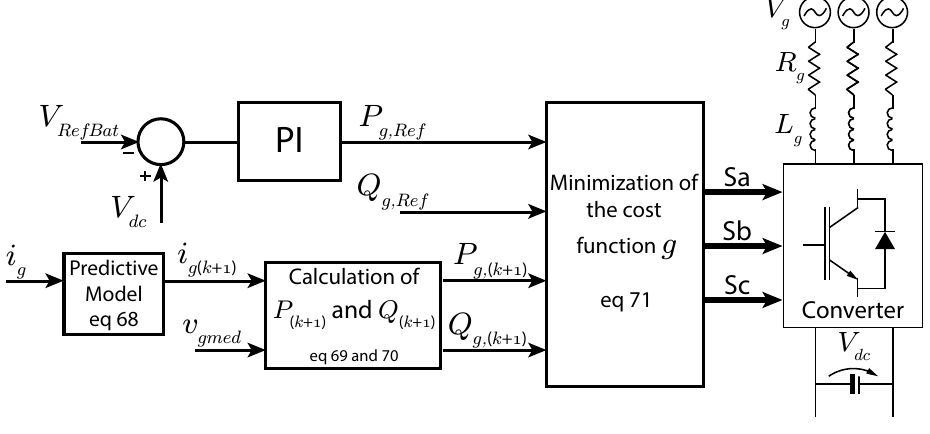
Figure 15. Finite control set diagram connected to the